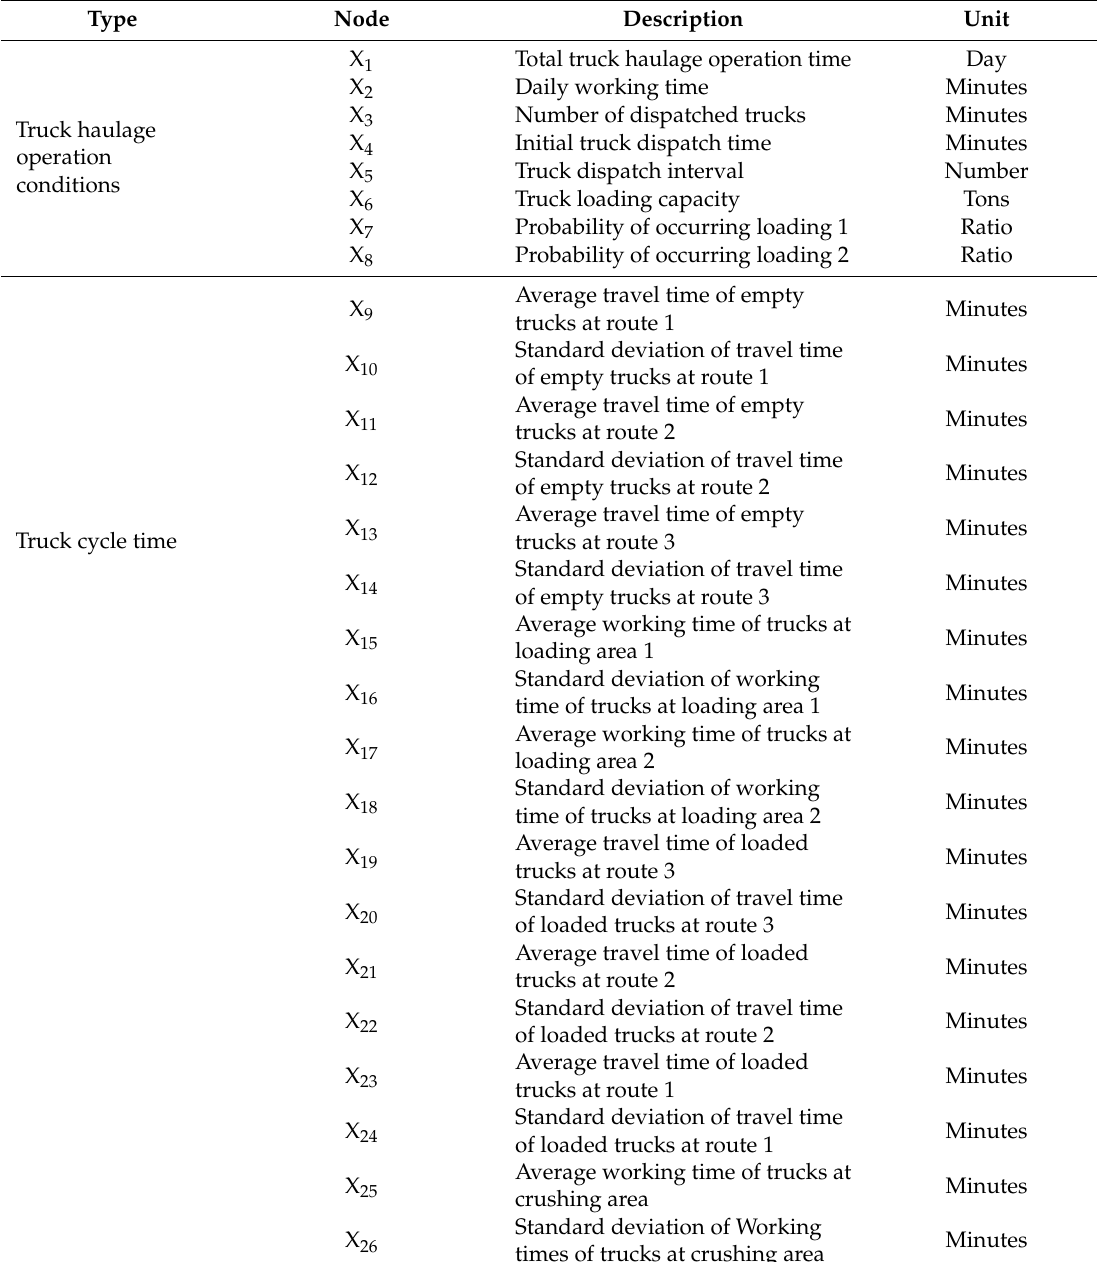
Table 1. Description of input nodes in DNN